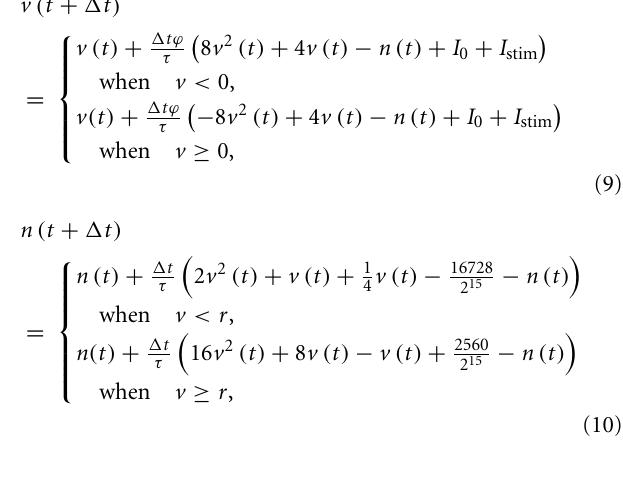
Frequency of repetitive firing in the Class I mode. (D) Phase plane in the Class II mode. I stim = 0. (E) Bifurcation diagram in the Class II mode. I 2 = 0.009, I 3 = 0.013. (F) Frequency of repetitive firing in the Class II